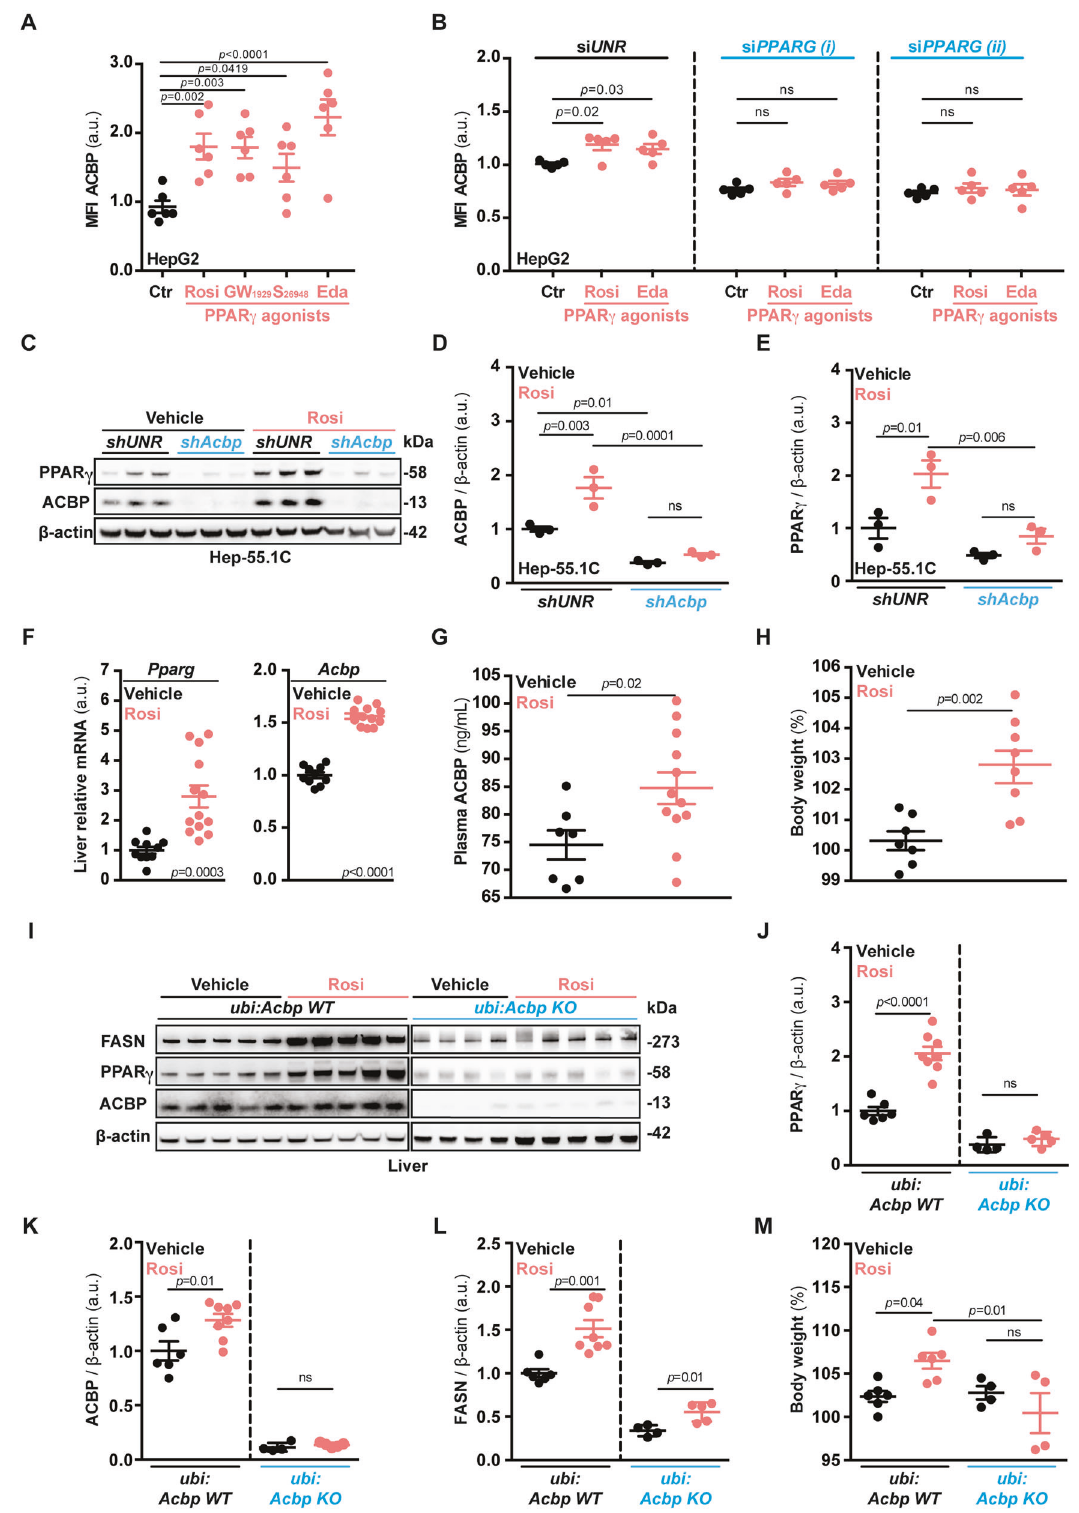
Fig. S6D, E) of HFD. In line with these observations, the HFD-induced triglyceride and cholesterol synthesis was decreased in the livers of Gabrg2 F77I/F77I I mice, suggesting compromised lipoanabolism (Fig. S6F – I). Of note, the aforementioned metabolic effects of Gabrg2 F77I/ F77I mice were not related to hypophagia (Fig.